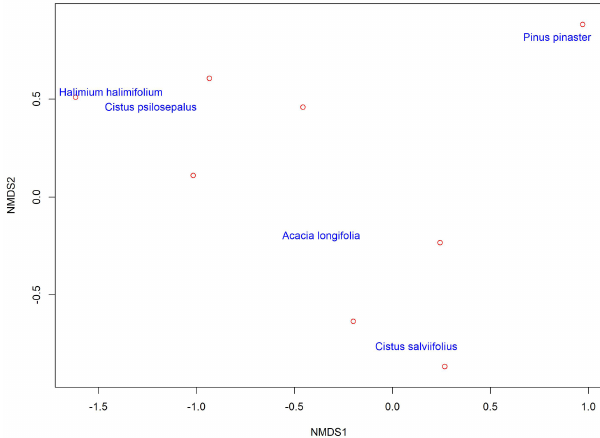
Figure 3. Non-metric multidimensional scaling (NMDS) of the plant-associated fungal communities, showing the clustering of similar communities in the two dimensions represented here. Plant communities are represented by the name of the plant species. Each red circle represents one identified fungal taxa except for Pinus pinaster , where the red circle represents three different fungal taxa, and Cistus salviifolius , where the red circle represents four fungal taxa.